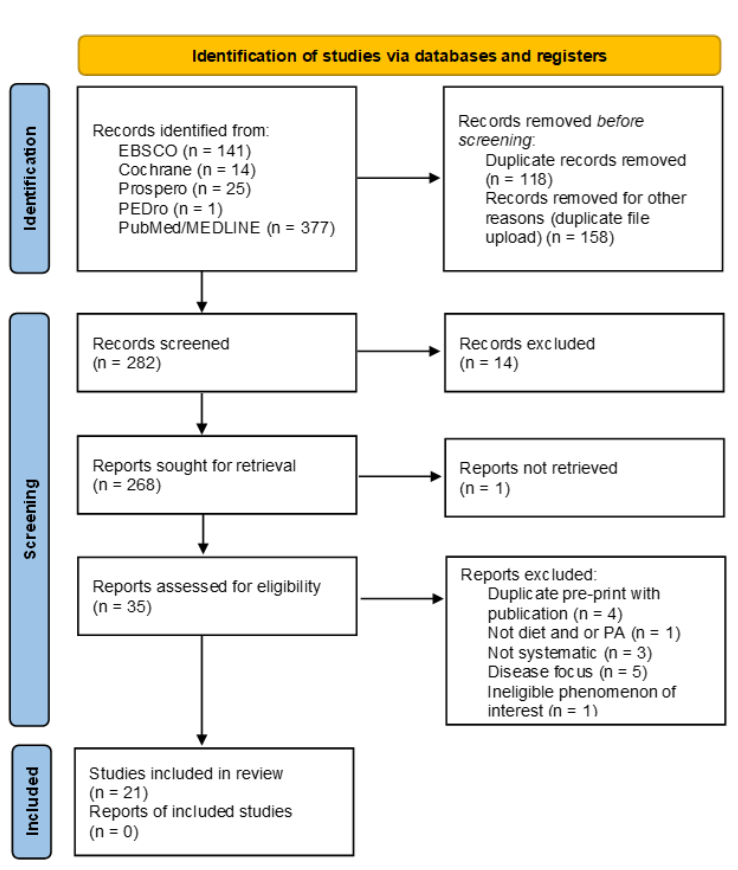
Figure 1. PRISMA-ScR flow